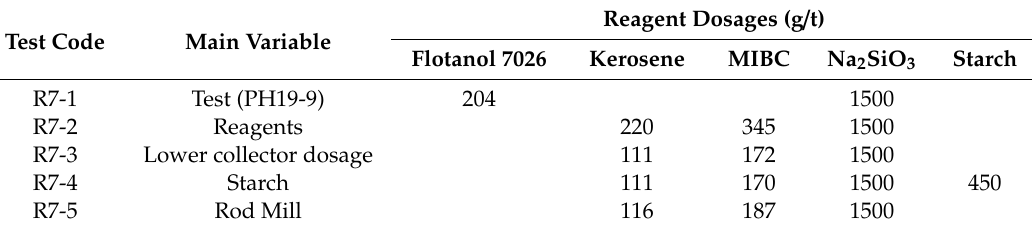
Table 1. Reagent types and dosage used for flotation